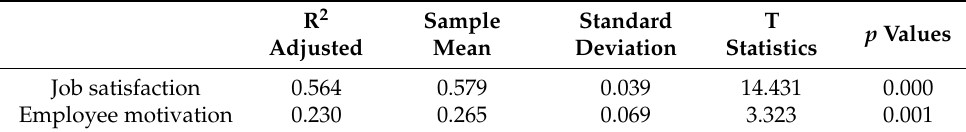
Table 7. R Square